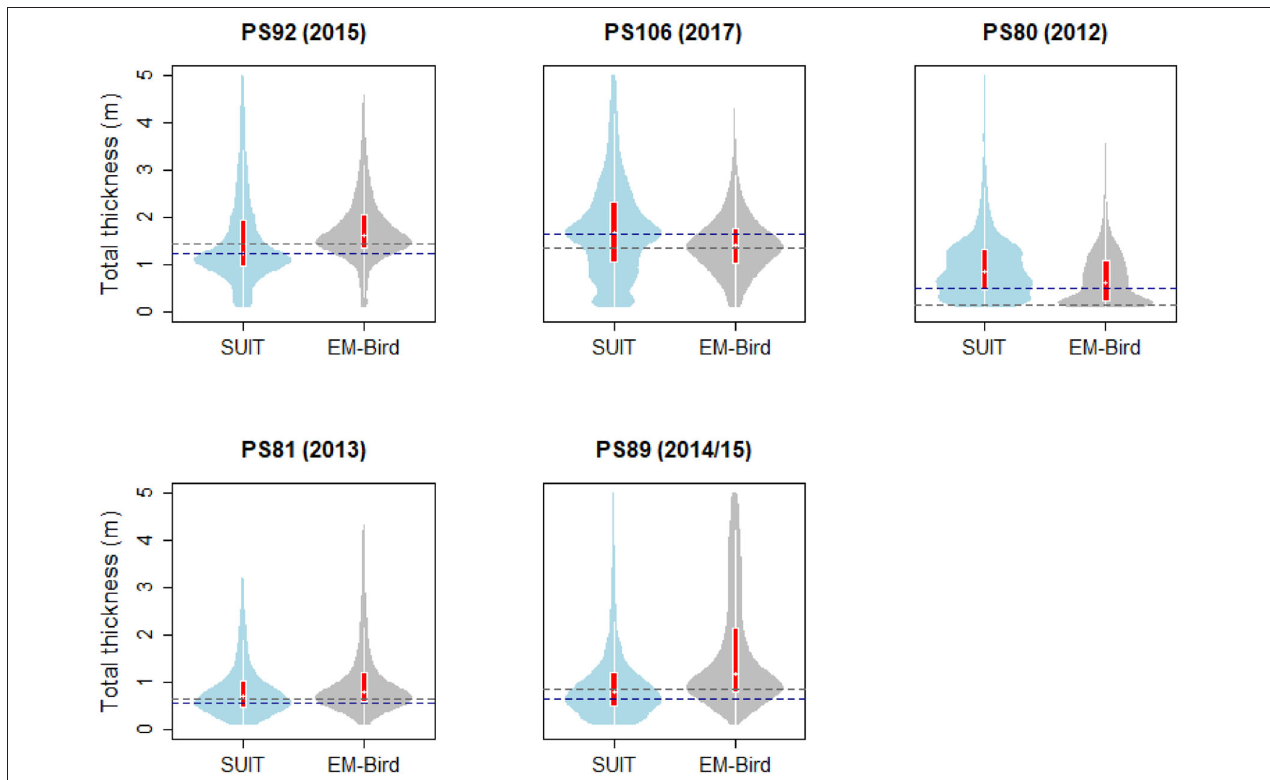
FIGURE 5 | Violin plots of total thickness (sea ice and snow) computed from the SUIT stations and from the EM-bird measurements in the vicinity of SUIT stations. The “violins” show density functions of the relative frequency distribution of the data. Superimposed on the violin plots are box plots showing the median (white dot), the 1st to 3rd quartile range (red boxes), and the lowest and highest data points within approximate 1.5 times the interquartile range (white lines extending from the boxes). Dashed lines indicate the modes of SUIT (blue) and EM-Bird (gray) data. Data were restricted to the interval 0.1–5.0m total thickness.